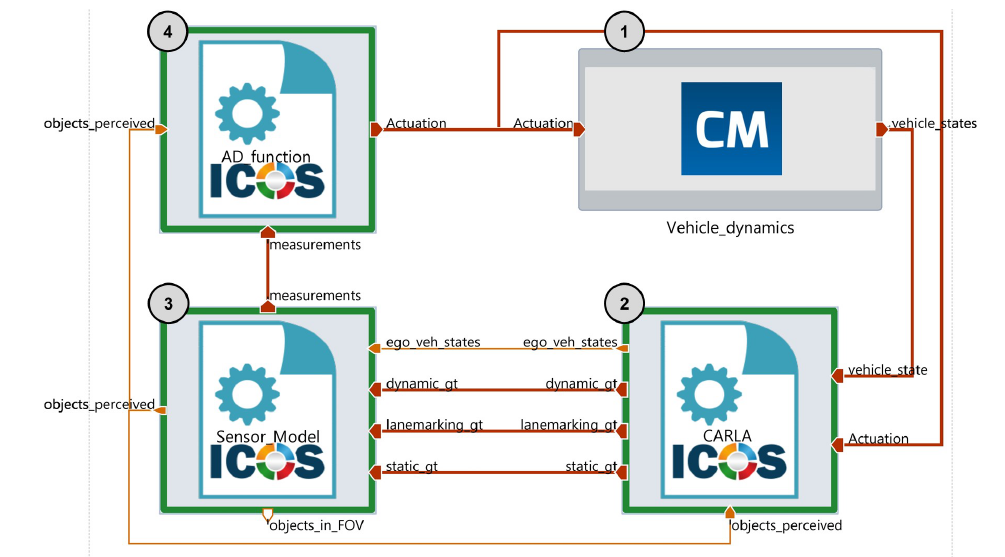
Figure 10. Overview of the implemented co-simulation architecture using AVL Model.CONNECT TM .